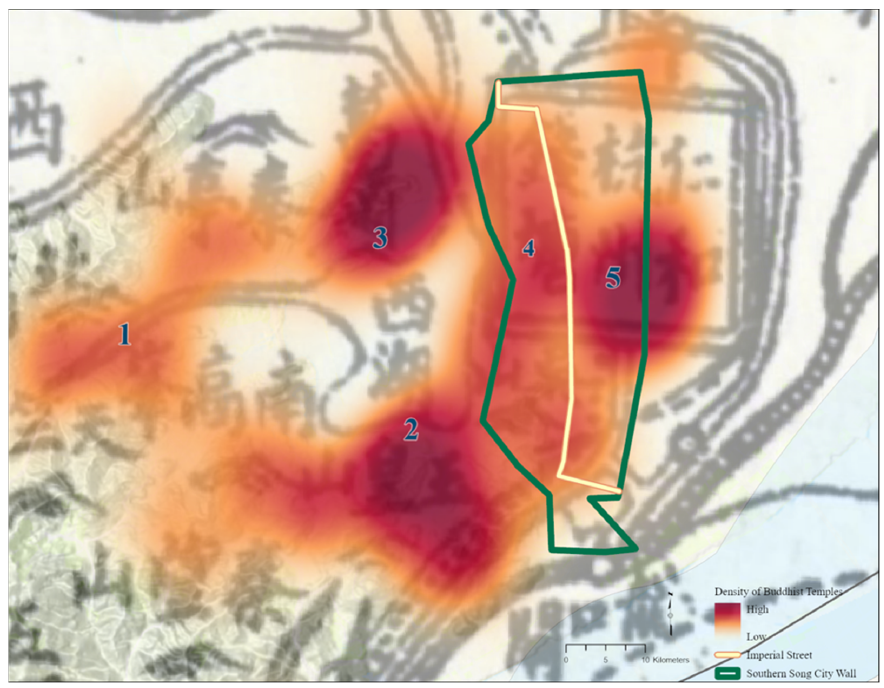
Figure 6. The Imperial Street ( yujie 御街 ) and hot zones from the result of kernel density analysis. Both sides of the Imperial Street were called the Imperial Corridor ( yulang 御廊 ), it was a national trading hub filled with regional goods from all over the country. Recorded in Nai Dewong’s 奈德翁 (date of birth and death unknown) Splendor Records of a Capital ( Ducheng jisheng 都城紀勝 ), “pearls and jewels, treasures and rarities, fresh flowers and fruits, seafood and wild food, marvelous implements and utensils, all the unique commodities in the world are assembled here in the morning.” (Nai 1982; Xie 2016). There were more than 150 stores on the Imperial Street that the historian Lin Zhengqiu 林正秋 divided into the following seven categories: daily groceries, restaurants, clothing, books and stationaries, medicine, pawnshops, and entertainment centers (Lin 1990). Almost half of the population within the city lived along this path—324 people per acre as estimated by Gernet, which approximately delineates Zones 4 and 5. (Gernet 1962). According to the Xianchun Lin’an zhi , the Imperial Street is explicitly built for the emperor’s seasonal ancestor worship (4 times per year) from the imperial palace to the Jingling Temple 景靈宮. The route of the emperor’s worship began from the imperial palace (on the southern end of the city) and ended at the northwestern corner of Lin’an city. In addition to the emperor’s ancestral worship, there were also many Buddhist festivals, birthday celebrations for the emperor or the empress, and rituals that royal members, government officials, and commoners participated in at Buddhist official temples. As mentioned in earlier sections, many official Buddhist temples were newly built by the Southern Song court along the Imperial Street (Zones 4 and 5) for the sake of serving the imperial family or government officials. For instance, the Mengliang lu 夢梁錄 documented that the Qianqing Guanghua Temple 千傾廣化院 was the venue for “praying for merits in the Lin’an Prefecture” and “governmental officials celebrating and praying for the emperor’s birthday.” (Wu 1980). Owing to those religious activities, many worship-related items were in demand in the proximity of the official Buddhist temples—including incense, candles, paper money, flowers, pastries, fruits, and exquisitely handcrafted artisan souvenirs. (Duan 2020; Chen 2013) The Mengliang lu recorded that whenever the emperor worshipped at the official